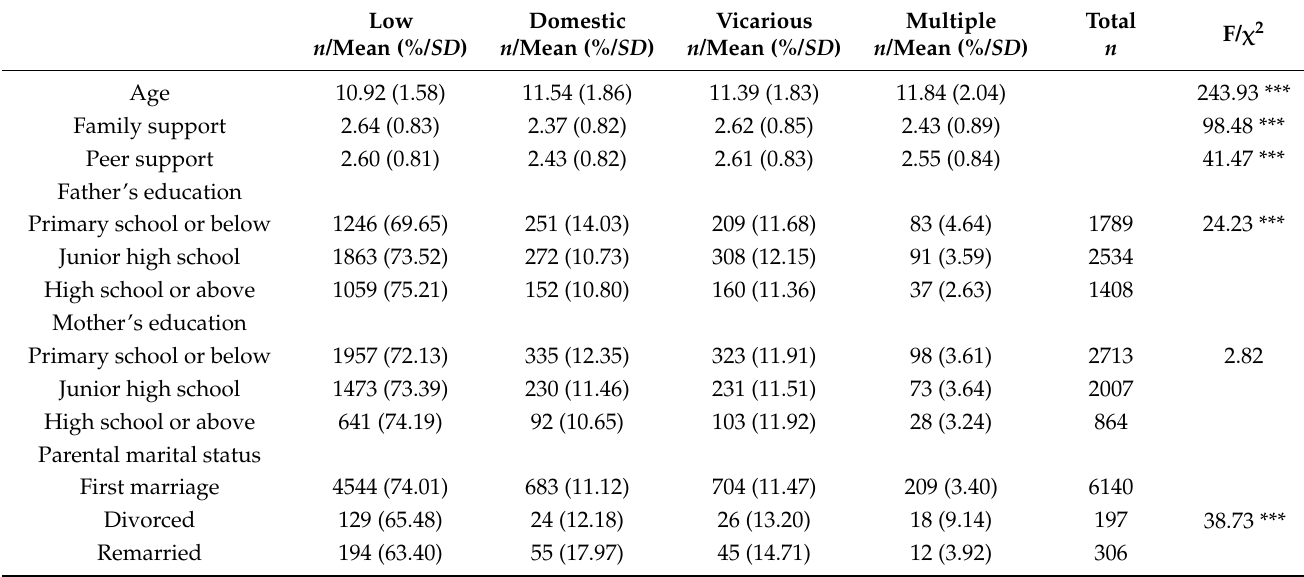
Table 4. Demographic variables of females according to classes of CTEs ( N = 6745).